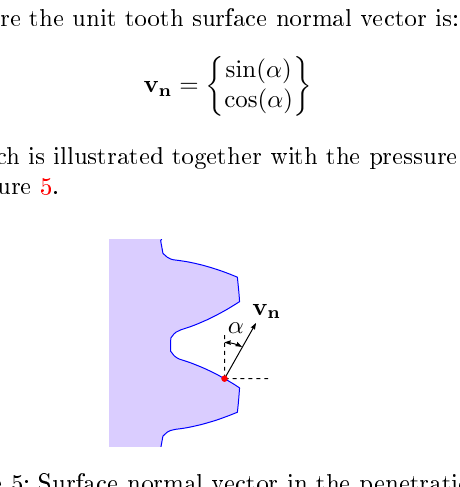
Figure 5: Surface normal vector in the penetration di- rection as a function of the pressure angle α